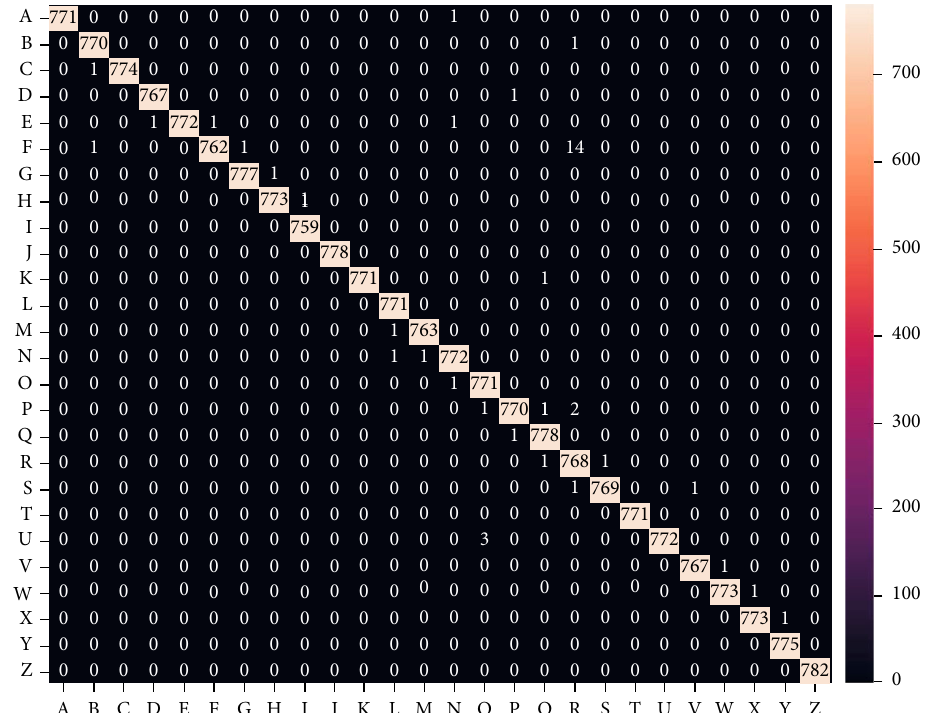
Figure 7: Confusion matrix for the RTC dataset for the proposed CNN-LSTM network.